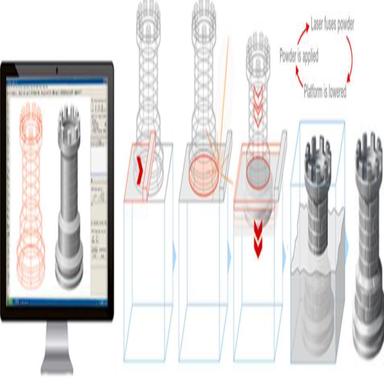
Representation of SLS (Adapted from ).